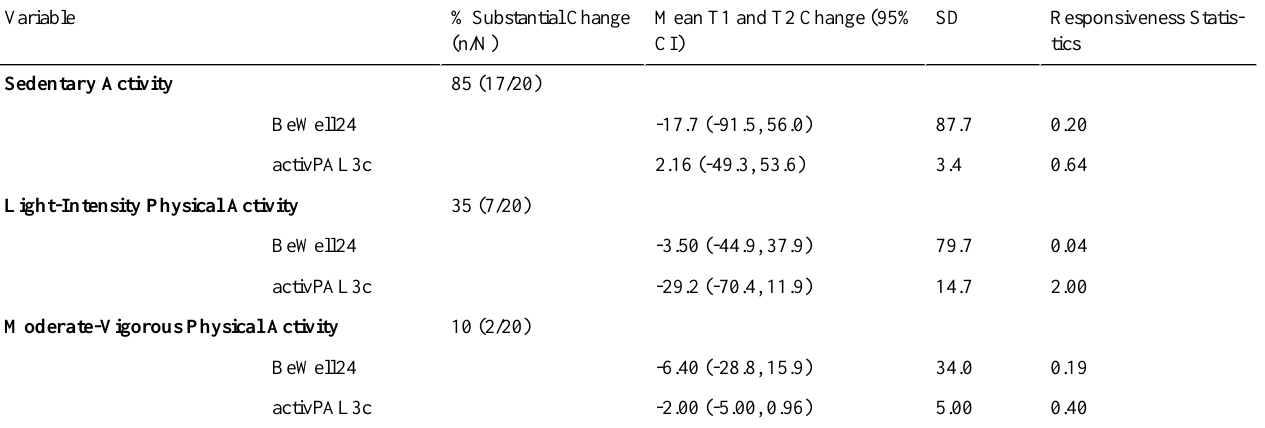
Table 2. Responsiveness to change of the BeWell24 app and activPAL3c (n=20).